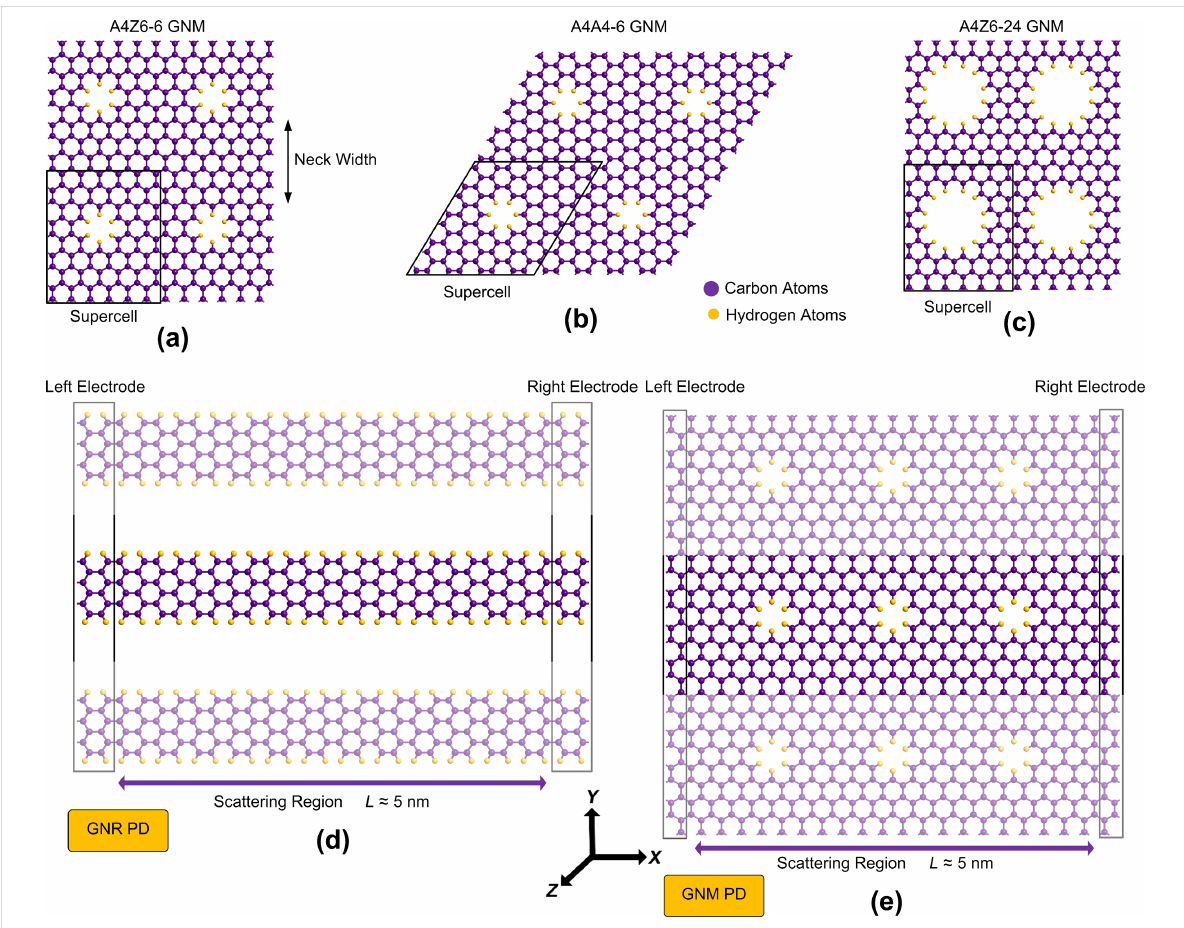
Figure 1: Graphene nanomesh structures. (a) A4Z6-6, (b) A4A4-6, and (c) A4Z6-24. Purple (larger) and yellow (smaller) spheres represent carbon and hydrogen atoms, respectively. Quadrilaterals with black lines represent the supercells of GNM. (d) A photodetector device made of GNRs with two source and drain contacts. The contacts are made of doped GNRs and the channel of device is periodic in the Y direction. (e) A photodetector device made of a GNM with two source and drain contacts. The contacts are made of graphene and the GNM channel of the device is periodic in the Y